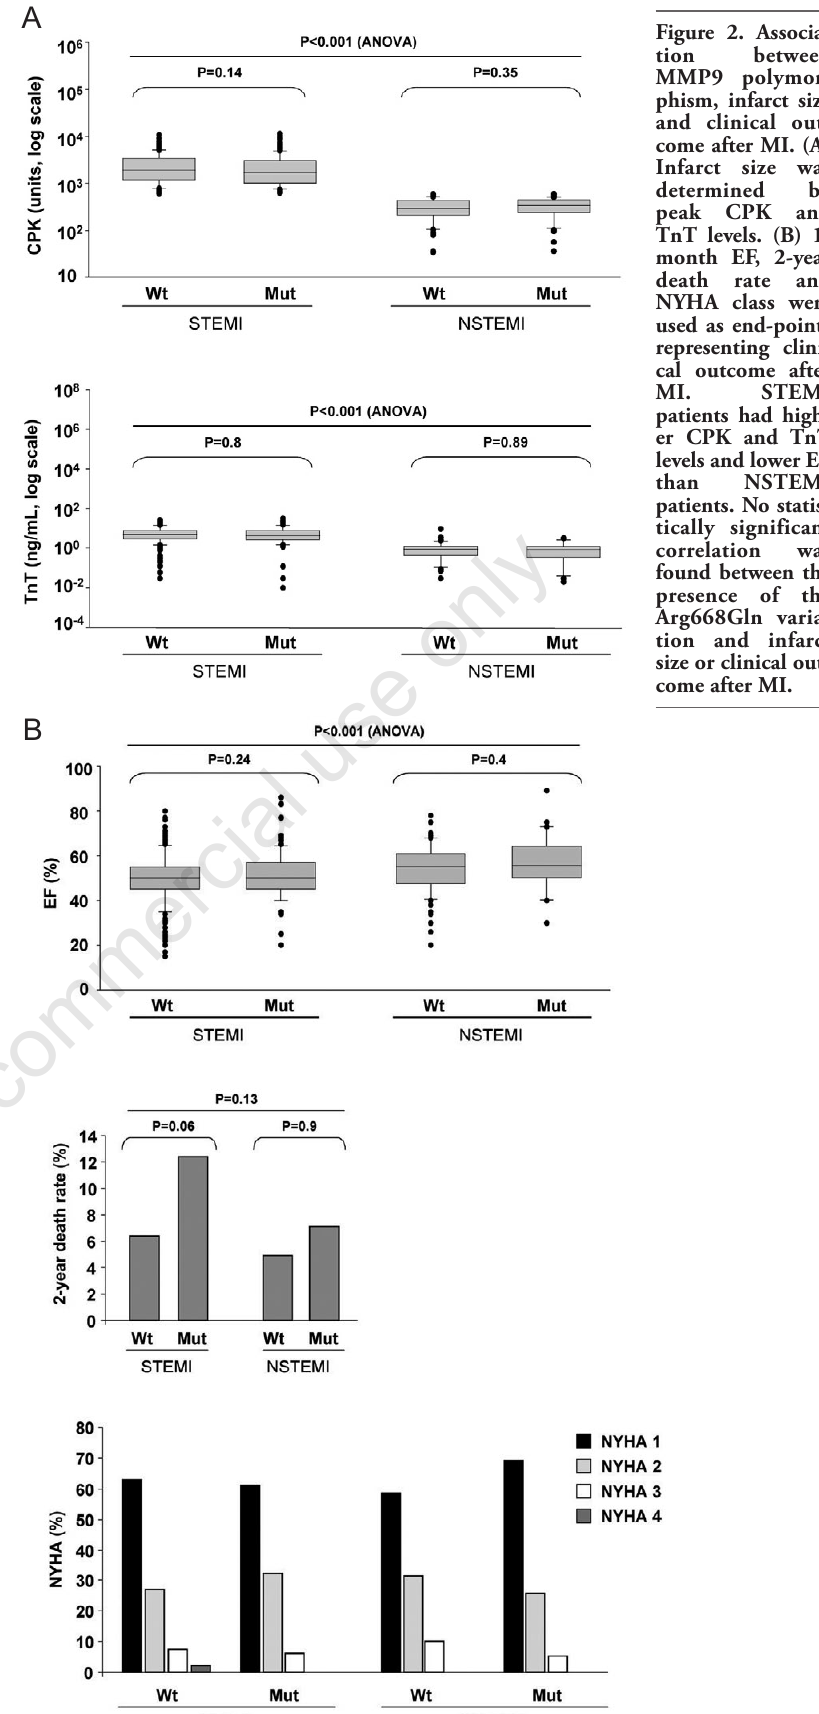
Figure 2. Associa - tion between MMP9 polymor- phism, infarct size and clinical out- come after MI. (A) Infarct size was determined by peak CPK and TnT levels. (B) 1- month EF, 2-year death rate and NYHA class were used as end-points representing clini- cal outcome after MI. STEMI patients had high- er CPK and TnT levels and lower EF than NSTEMI patients. No statis- tically significant correlation was found between the presence of the Arg668Gln varia- tion and infarct size or clinical out- come after MI.